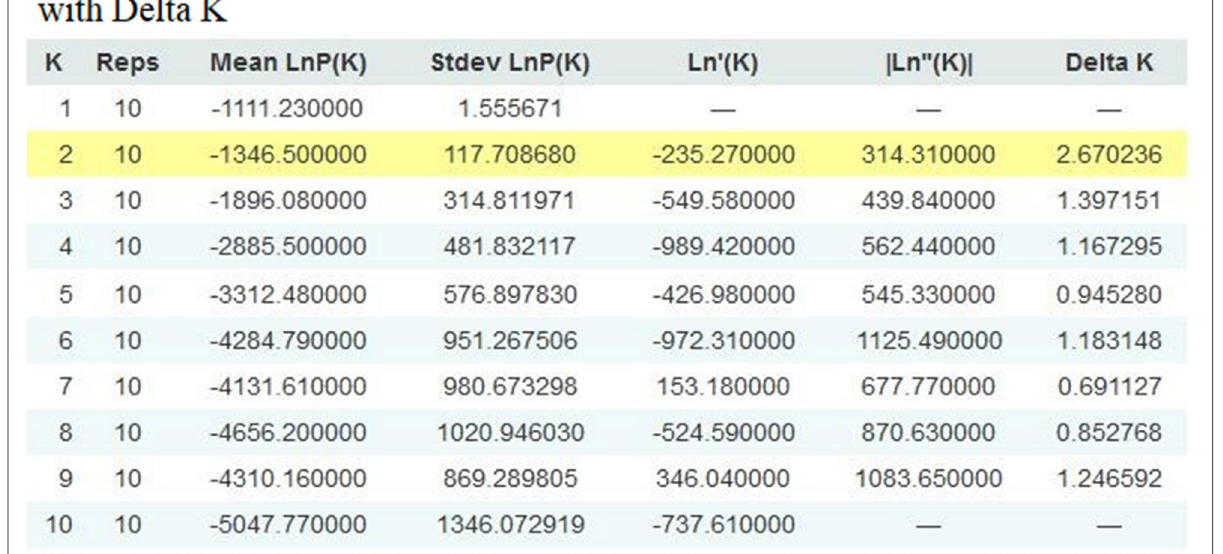
Fig. 5 Evanno table with mean and standard deviation of log-likelihood values along with Delta